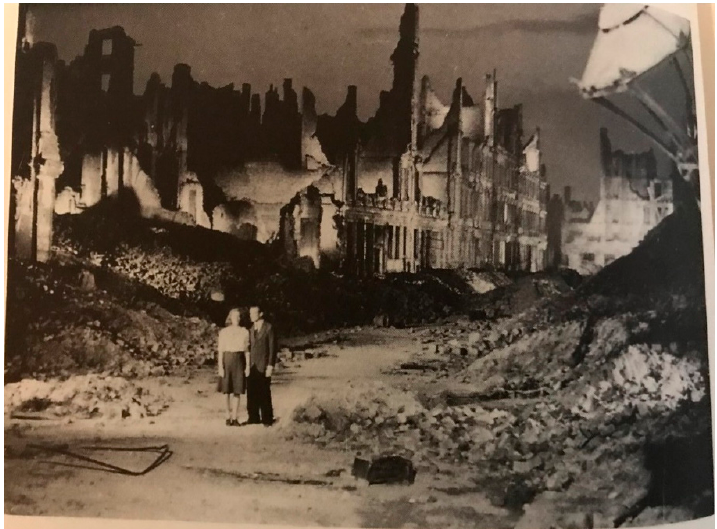
Figure 14. Unknown. Illuminated Ruins for the Shooting of the DEFA Film The Murderers Are Among Us with Hildegard Knef and Wilhelm. DEFA-Stiftung. Us with Hildegard Knef and Wilhelm.